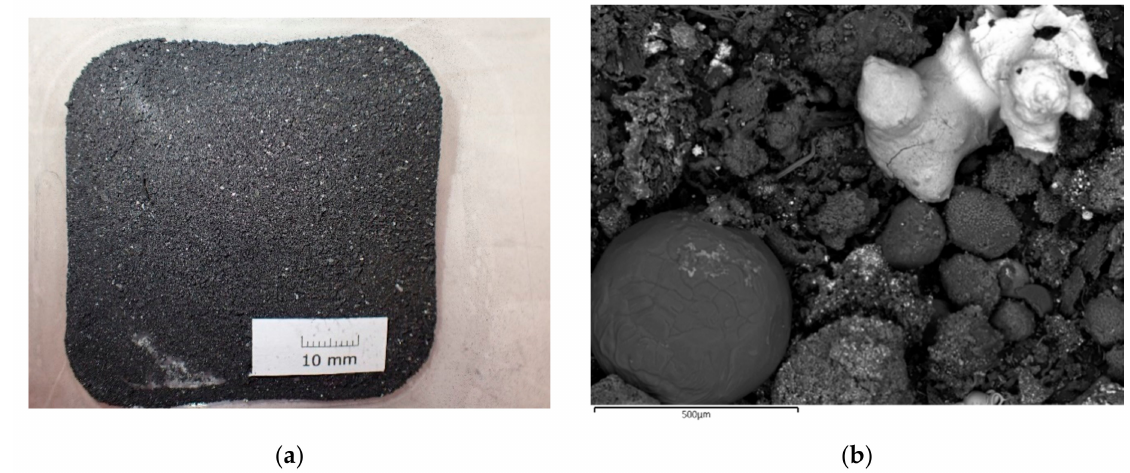
Figure 6. ( a ) Image of the remaining powder after the product examination of the NMC622 trial. ( b ) SEM image of the powder phase from NMC622 under 100-fold zoom.